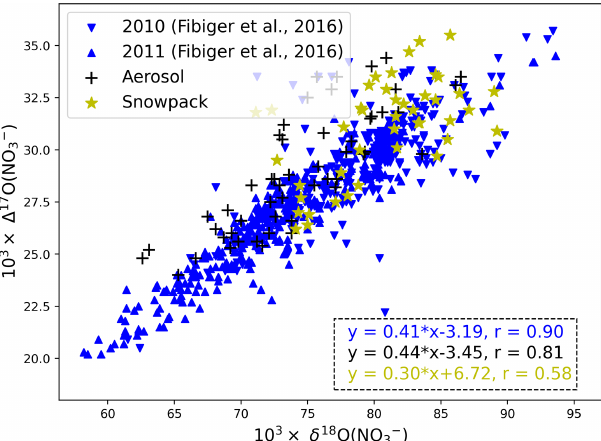
Figure 4. Relationship between (cid:49) 17 O(NO − ) and δ 18 O(NO − ) for 3 3 all atmospheric (this study), surface snow (Fibiger et al., 2013) and snowpack data (Geng et al., 2014). Note the Fibiger et al. (2013) data were only for 4 months (May to June in 2010 and 2011), and the abnormal (cid:49) 17 O(NO − ) value less than 20‰ was abandoned. 3